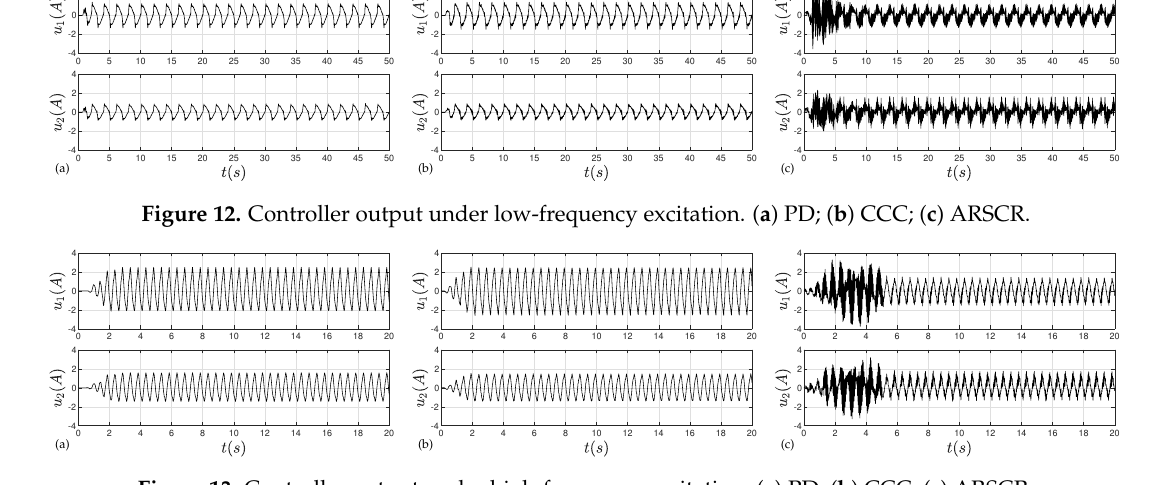
Figure 13. Controller output under high-frequency excitation. ( a ) PD; ( b ) CCC; ( c )